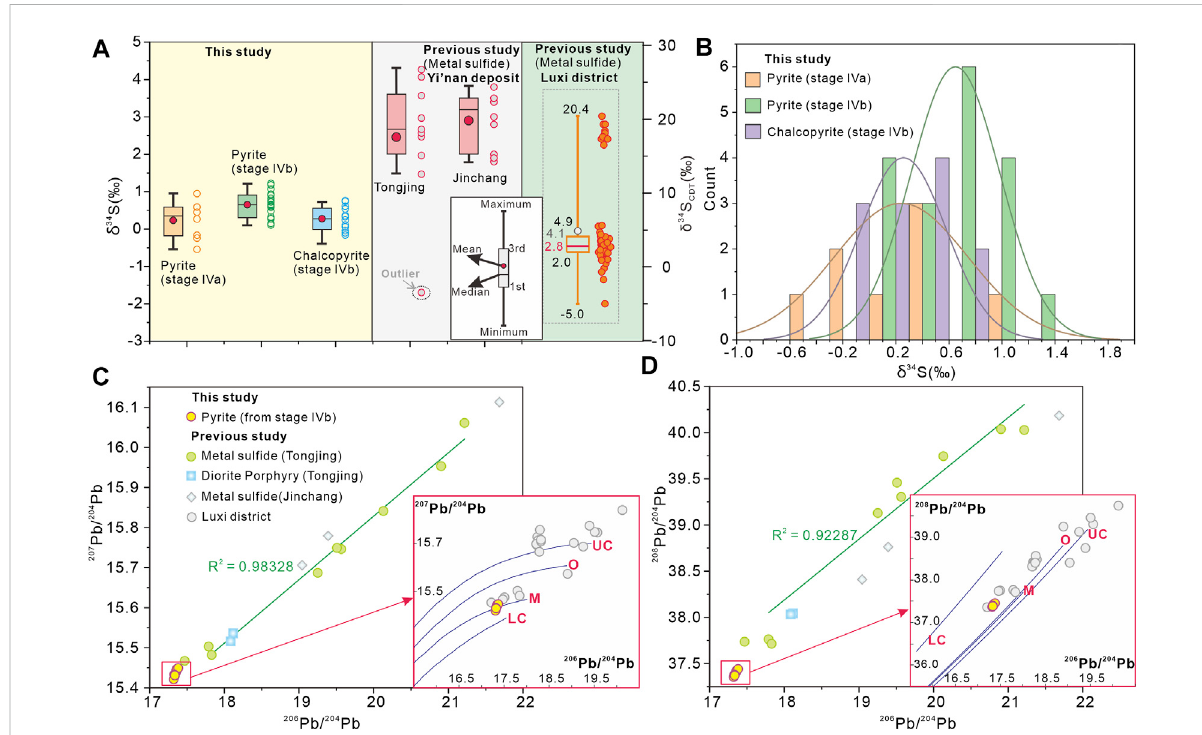
FIGURE 10 (A) . Sulfur isotope compositions of various sul fi de minerals in the Yi ’ nan Tongjing Au-Cu deposit; (B) . The histogram of sulfur isotope compositions; (C) . 206 Pb/ 204 Pb vs 207 Pb/ 204 Pb diagram; (D) . 206 Pb/ 204 Pb vs 208 Pb/ 204 Pb diagram (Zartman and Doe, 1981). The data from the previous study were obtained from Wan et al., 1992; Qiu et al., 1996; Lin et al., 1997; Hu et al., 2007; Li et al., 2009; Shi, 2014; Zhu, 2014; Tian et al., 2015; Abbreviations: LC = lower crust; UC = upper crust; O = orogen; M =